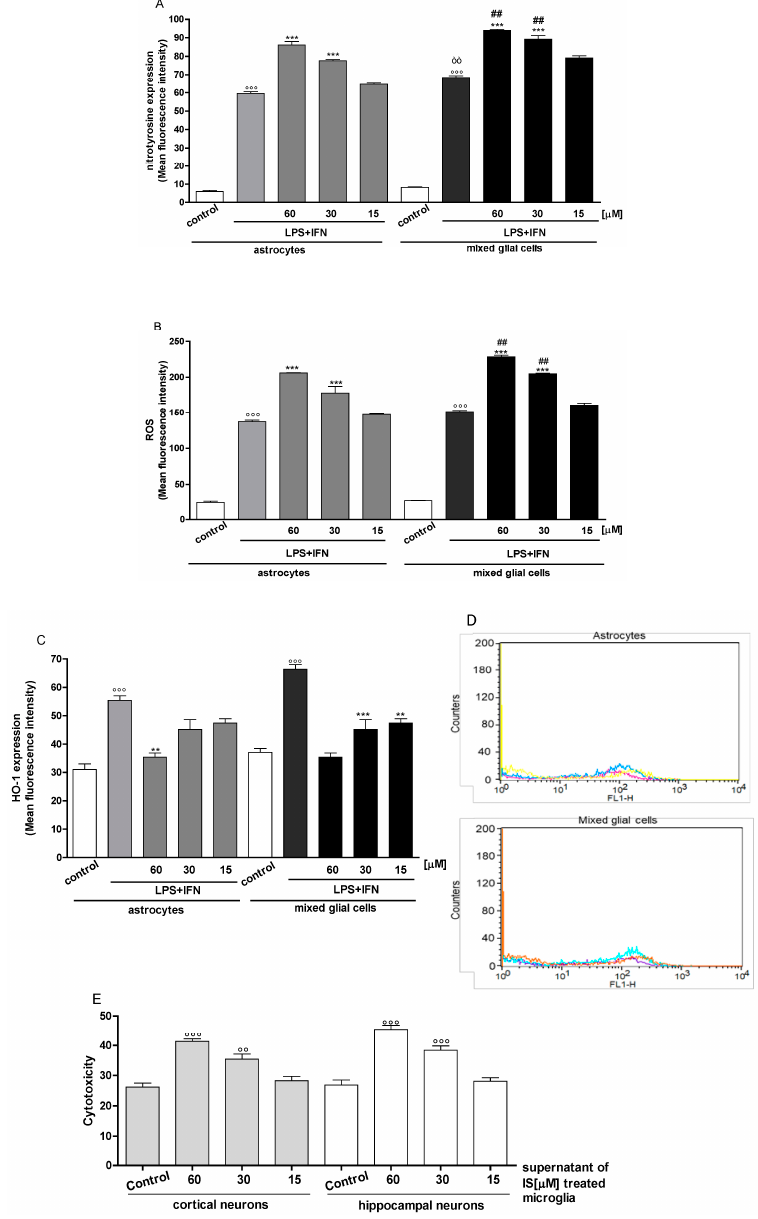
Figure 4. Effect of IS (60, 30 and 15 µM) on primary CNS cells treated with LPS (1 µg/mL) + IFN (100 U/mL) on nitrotyrosine formation ( Panel A ), and on ROS release ( Panel B ), evaluated by means of the probe 2’,7’ dichlorofluorescein-diacetate (H 2 DCF-DA) and on HO-1 expression ( Panel C ) in prmary astrocytes and mixed glial cells. Cellular fluorescence was evaluated using fluorescence-activated cell sorting analysis (FACSscan; Becton Dickinson) and elaborated with Cell Quest software. Panel D shows the representative fluorescence images for HO-1 expression (for primary astrocytes the pink line represent the cellular control, the blue line represent LPS + IFN, the yellow line represent IS 30 µM in presence of LPS + IFN; for mixed glial cells the violet line represent the cellular control, the light blue line represent LPS + IFN, the orange line represent IS 30 µM + LPS + IFN). Panel E shows the effect of supernatant from IS-treated microglia on cortical and hippocampal neuronal cell viability. Values are expressed as mean fluorescence intensity or as cell citotoxicity. Comparisons were performed using a one-way analysis of variance and multiple comparisons were made by Bonferroni’s post test. °°°, °° denote p < 0.001 and p < 0.01 vs. control. ***, ** denote p < 0.001 and p < 0.01 vs. LPS + IFN. òò denotes p < 0.01 vs. astrocytes treated with LPS + IFN. ## denotes p < 0.01 vs. astrocytes treated with IS + LPS + IFN.